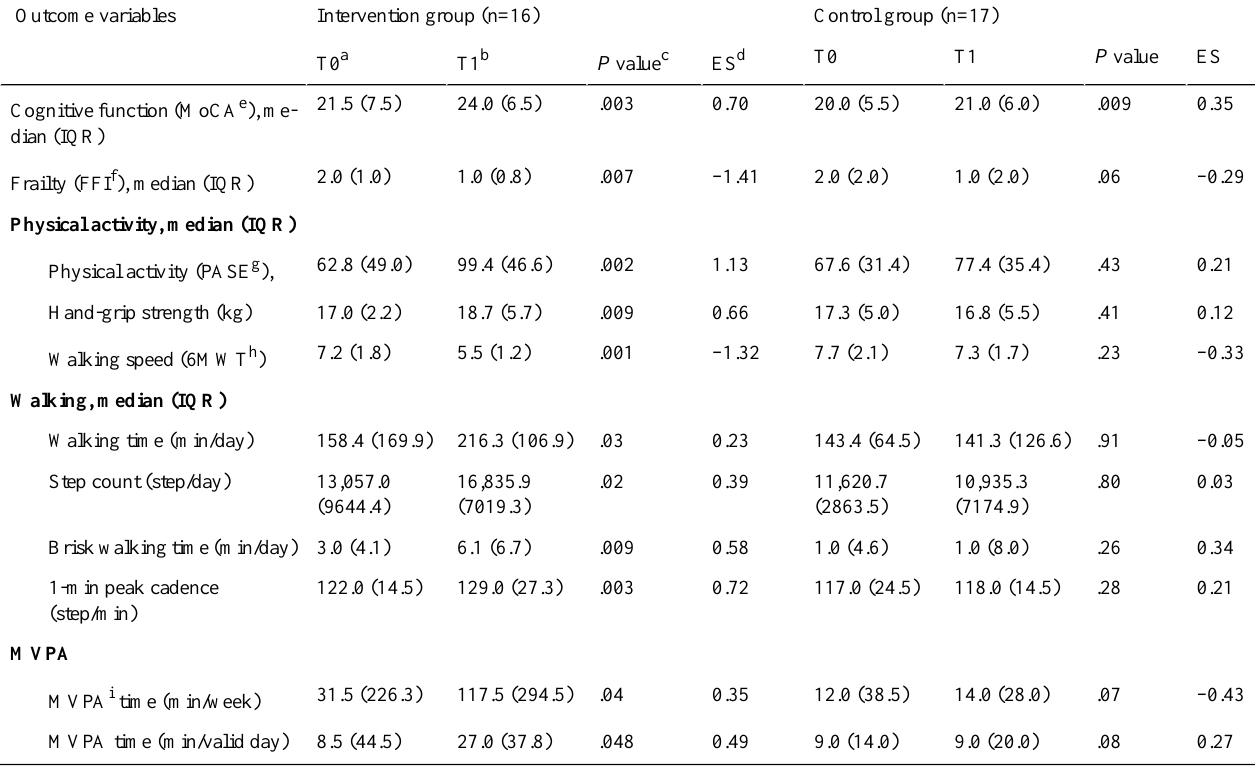
Table 7. Within-group effects of the interventions before and after the interventions in each group.